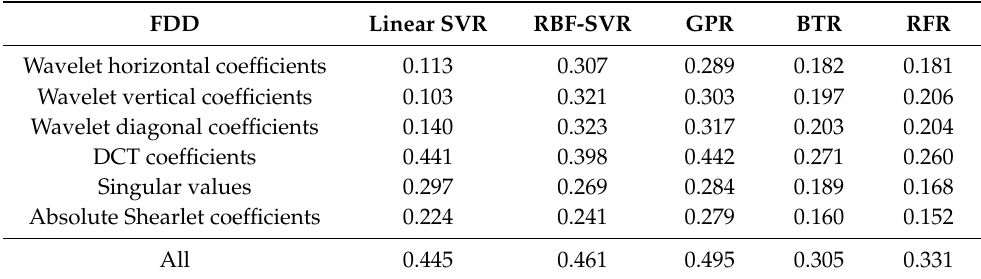
Table 7. Comparison of different FDD feature vectors extracted from different domains and different regression modules on SCID [47] database. Median SROCC values were measured over 1000 random train–test splits.